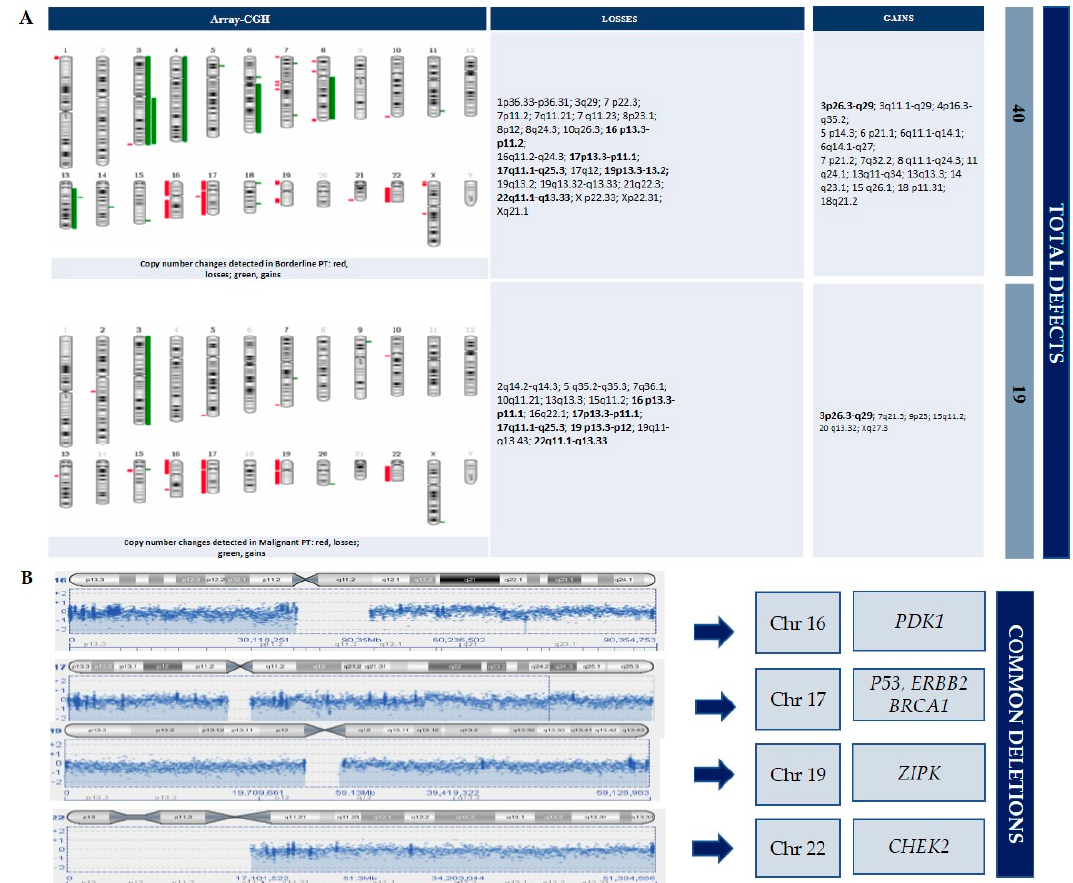
Figure 4. CGH-array results in borderline and malignant phyllodes tumor. ( A ) Shows all losses and gains in the borderline and malignant tumor, respectively. The alterations shared between the two entities are marked in bold. ( B ) The common deletions are listed.